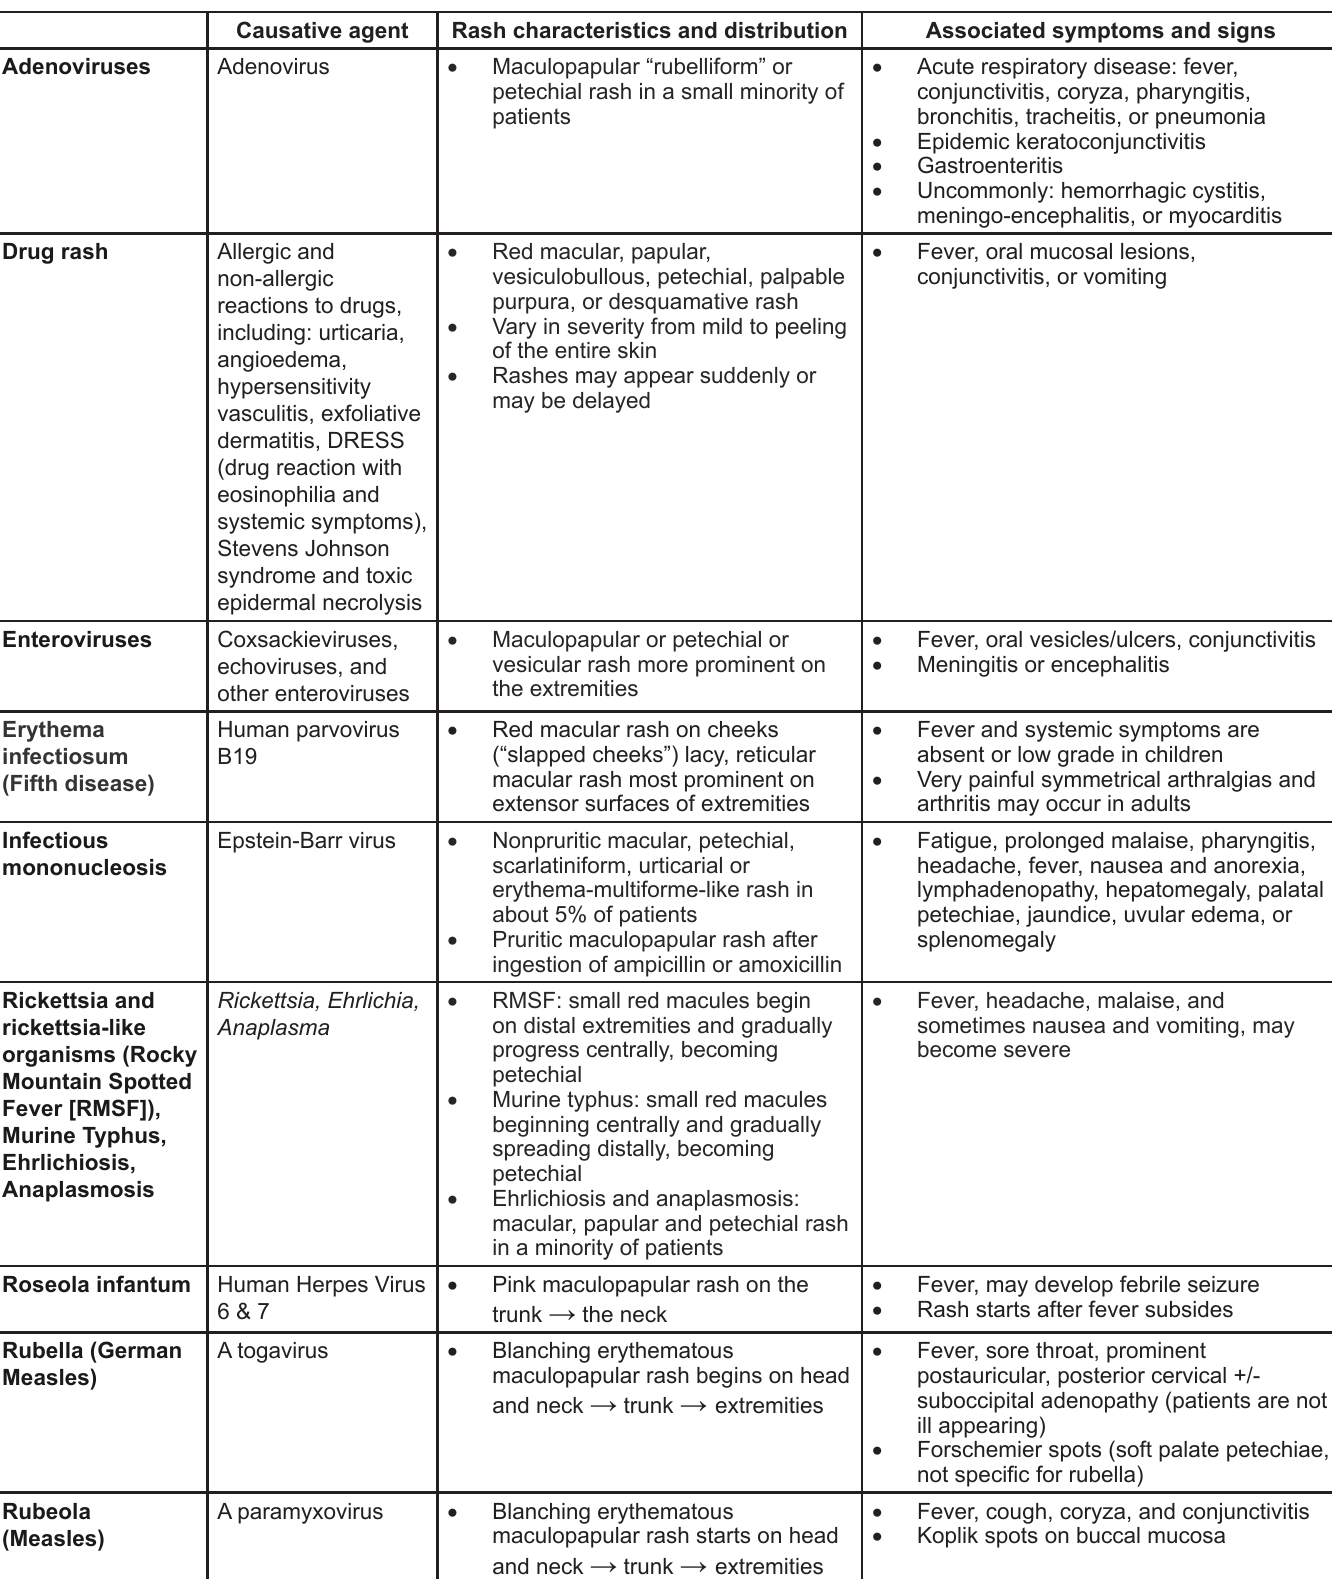
Figure 5 . Pediatric exanthems that may mimic